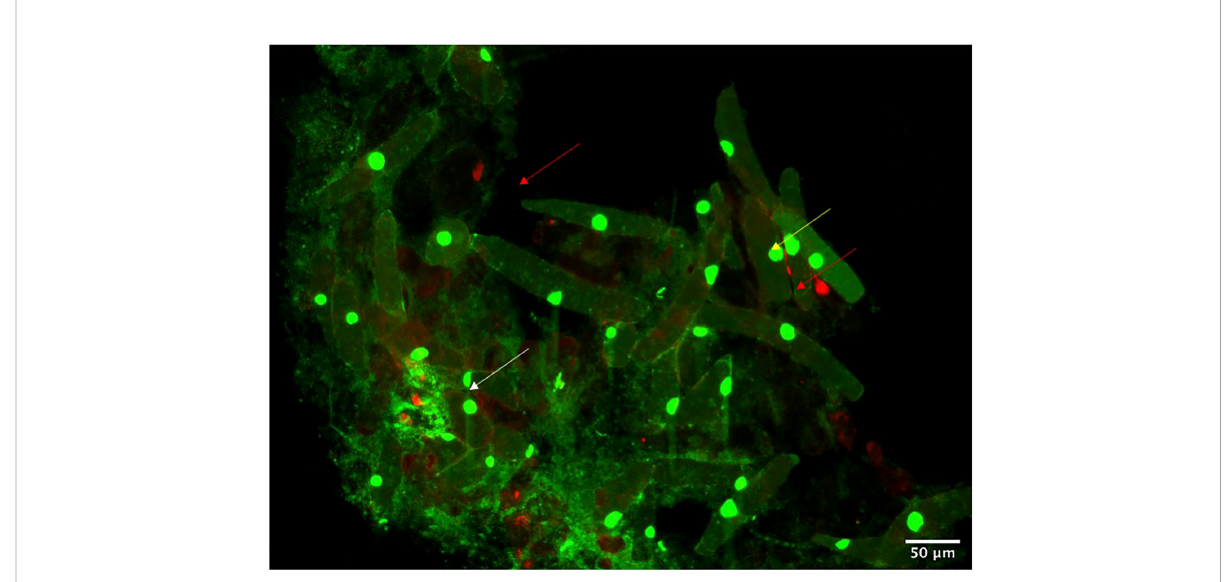
FIGURE 7 Root Border Cells from maize detach from the aerial root cap and remain in the mucilage environment. Fluorescent microscopy of border cells stained with propidium iodide marks dead cells (red arrows), and acridine orange marks viable cells (yellow arrows). White arrows indicate bacterial colonies trapped or attached to the border